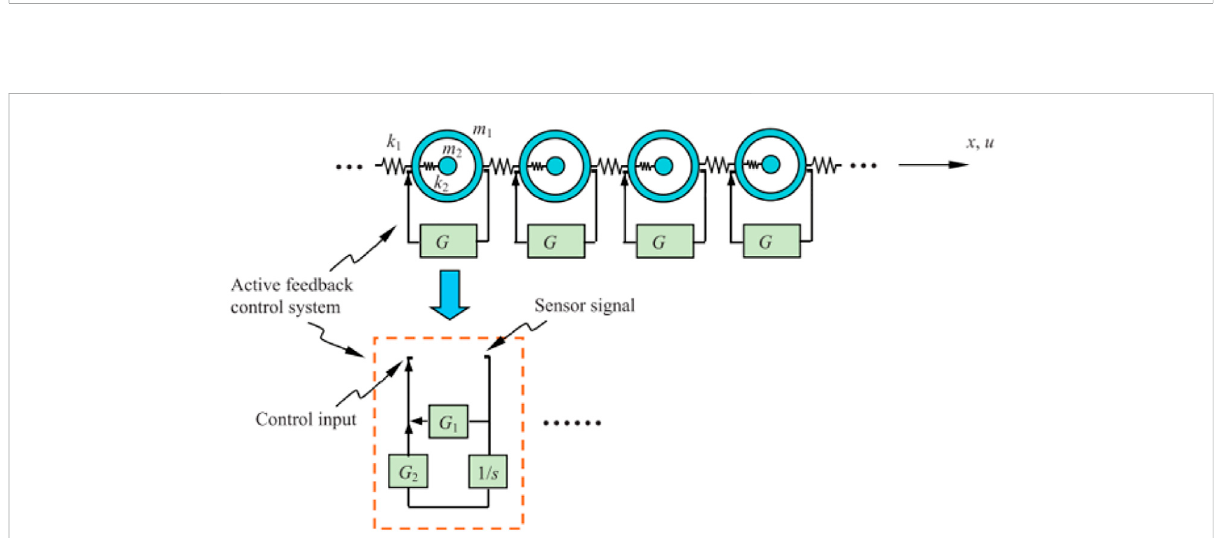
FIGURE 10 Elastic wave metamaterials with active feedback control system. Reprinted from [55] with